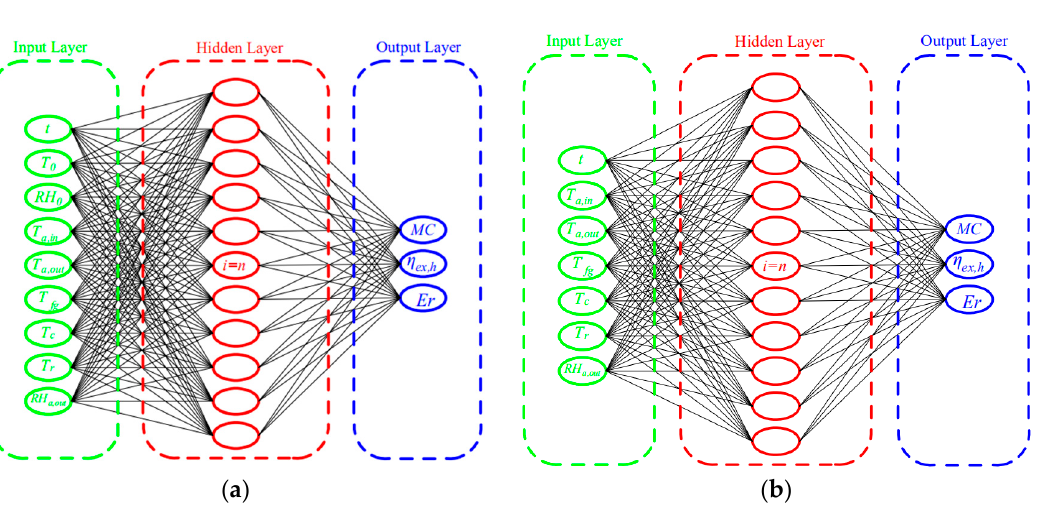
Figure 4. The train process of the established models. 2.7.6. Experimental Data The experimental test was conducted from 16 October to 19 November, 2019, in Xinzhou, Shanxi Province, China. During the test period, the local ambient temperature changed a lot (e.g., the T 0 on 16 October varies from 8.6 to 12.8 °C while the T 0 on 17 November varies from − 6.2 to 0.32 °C). In order to investigate the influences of ambient conditions on the drying behavior of the drying system, 327 groups of drying data for three days (17 October, 30 October, and 19 November) with significant T 0 difference were selected to be analyzed in the present work. The experimental data were measured every 5 min interval, and the data with obvious errors (e.g., the imprecise measurement of the grain moisture sensor caused by the ice phenomenon inside the grain at the beginning of the test, or the random error caused by the system failures) were eliminated during the process. The selected data